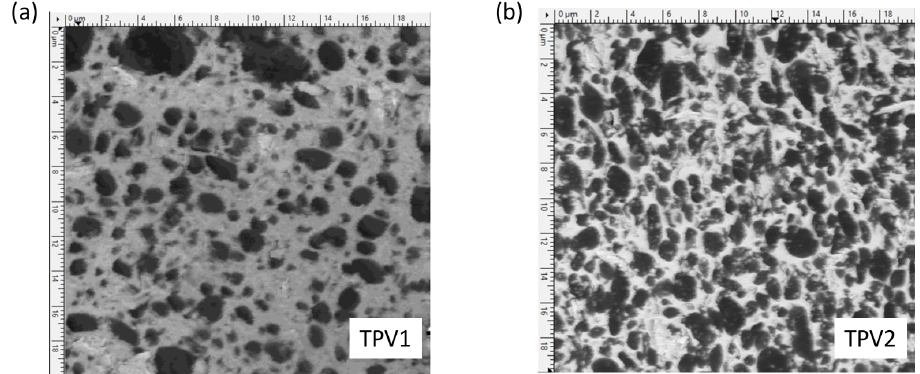
Figure 14. AFM phase image of TPV under study: ( a ) TPV1, injection grade. ( b ) TPV2, extrusion grade. The bright areas correspond to the thermoplastic phase (PP) and the dark areas correspond to the elastomer phase (EPDM). (images size (20 × 20) µ m 2